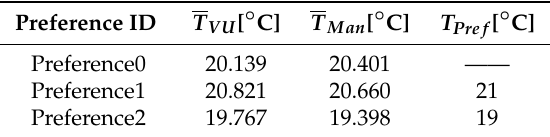
Table 1. Comparison of the average values of temperature for the VU-enabled profiling and for the manually-set profile, and the preferred temperature, for each identified